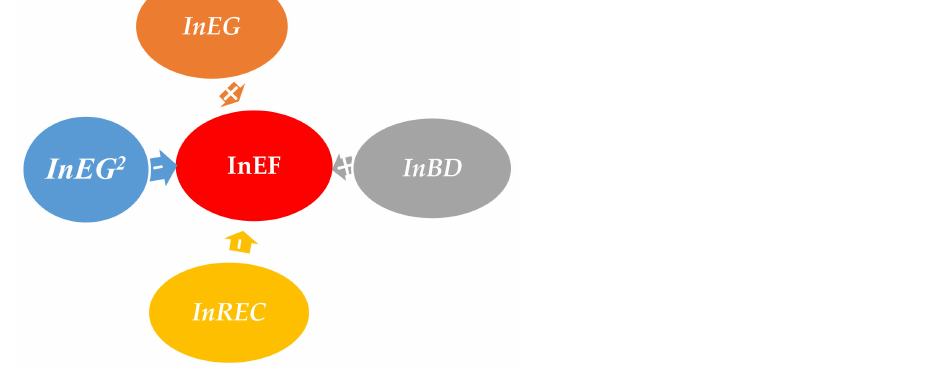
Figure 1. Graphical abstract for summarizing results of CCEMG, AMG, MMQR approach & causality